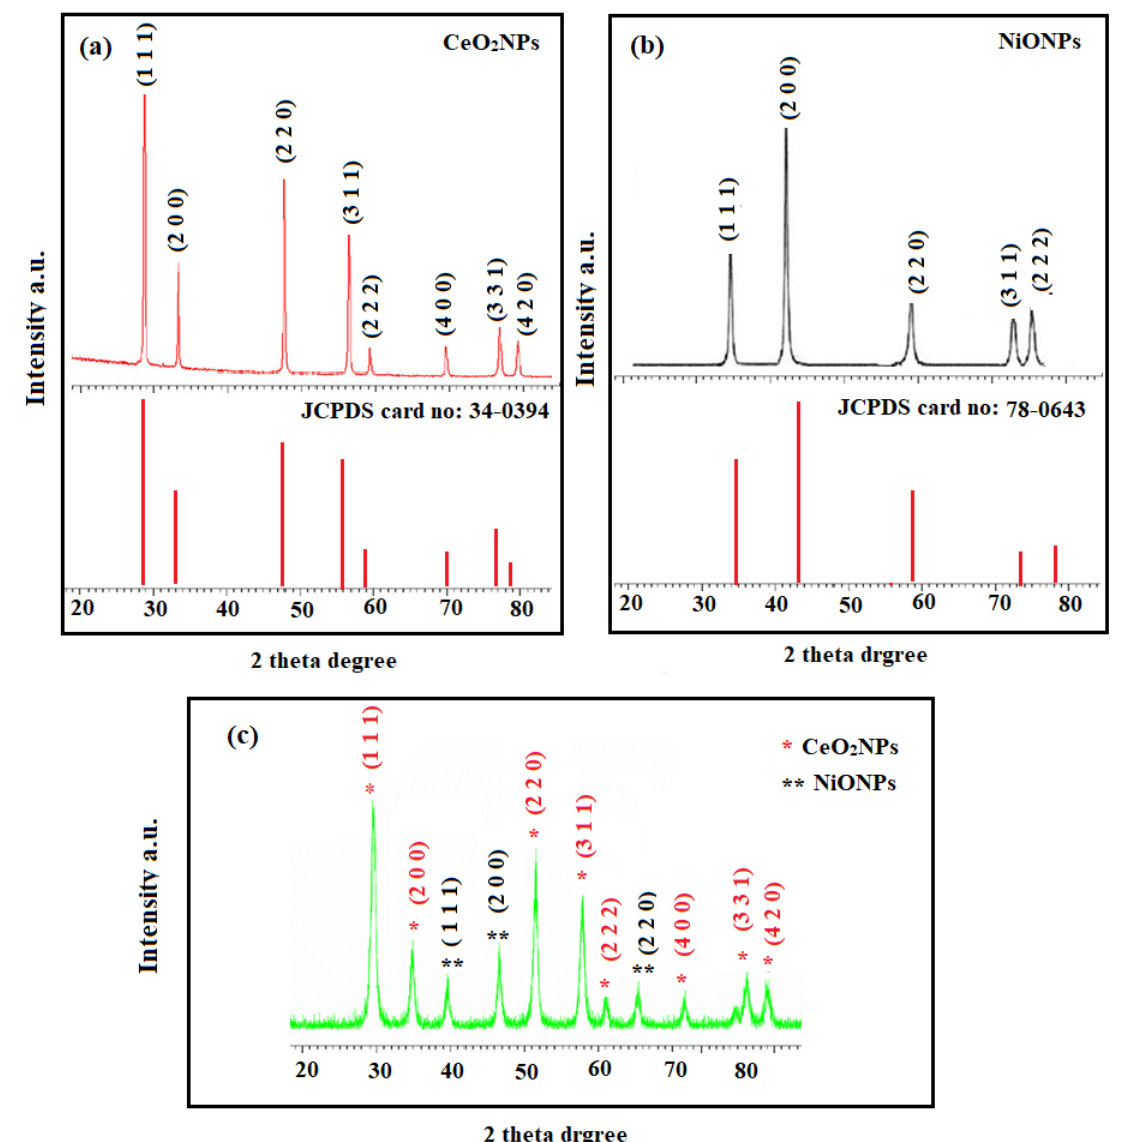
Figure 3. XRD spectra of ( a ) CeO 2 NPs (wheat husk extract) and ( b ) NiONPs (rice husk extract) and ( c ) their nanocomposite CeO 2 /NiO measured at 2 θ values in the range from 20–80 Å .